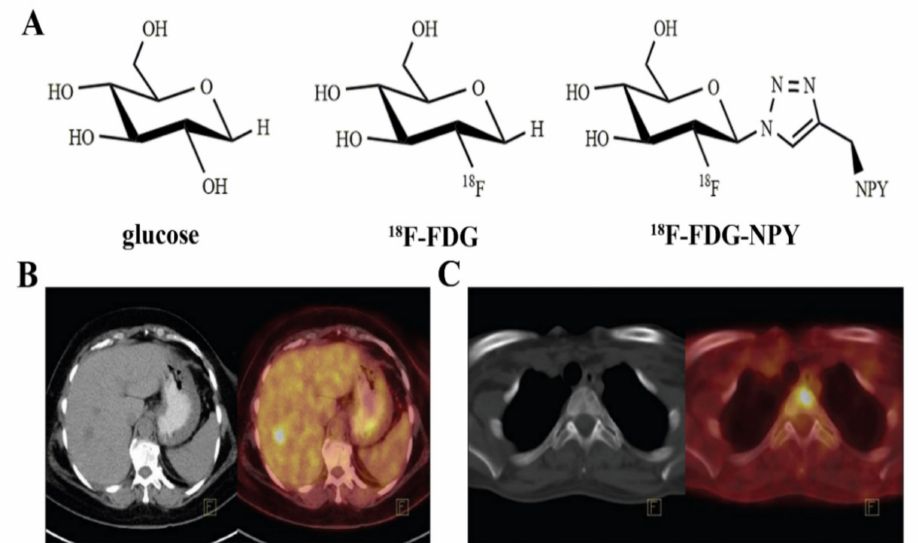
Figure 2. Chemical structure of ( A ) glucose, 18 F-FDG, and 18 F-FDG-NPY; ( B ) an invasive ductal carcinoma patient with a liver lesion at the right lobe, segment 5 [33]; ( C ) a female patient with infiltrating lobular carcinoma. 18 F-FDG PET/CT detected multiple bone metastases [33]. 18 F-FDG imaging can be used for breast cancer staging, molecular subtype